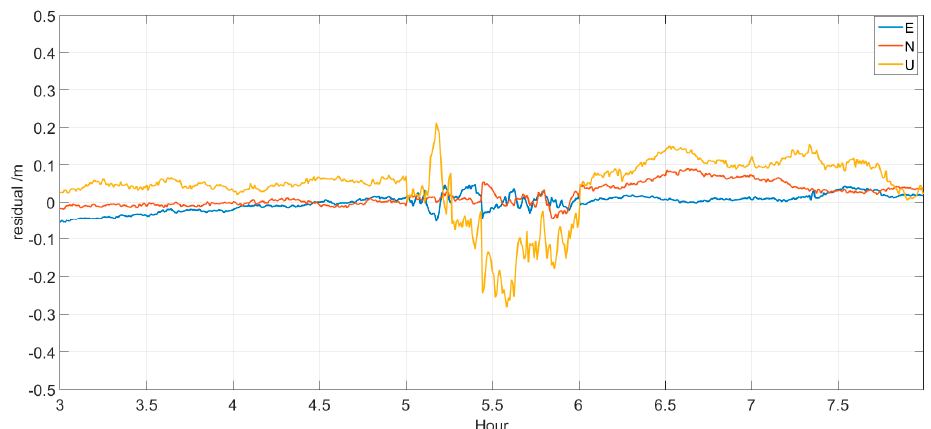
Figure 9. Residuals of kinematic PPP for BJFS. Sensors 2017, 17, 1308